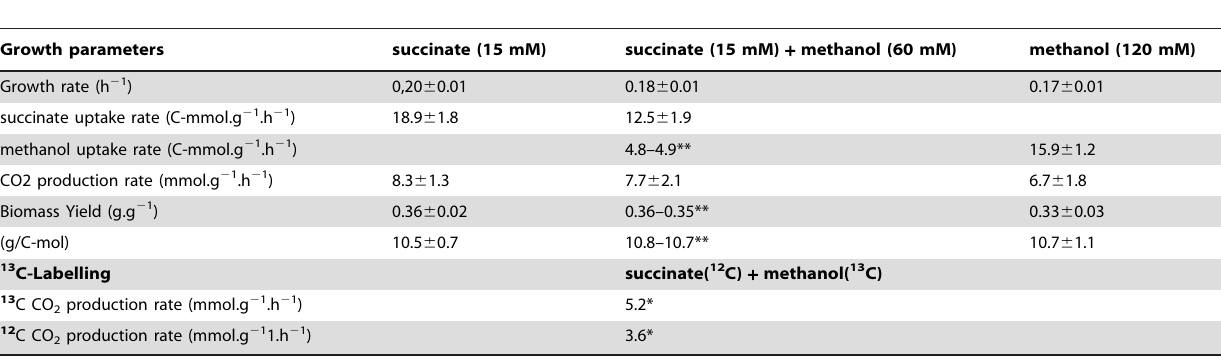
Table 1. Growth parameters of M. extorquens AM1 cells growing in batch-culture in minimal medium with 120 mM methanol, or 15 mM succinate, or 60 mM methanol plus 15 mM succinate.